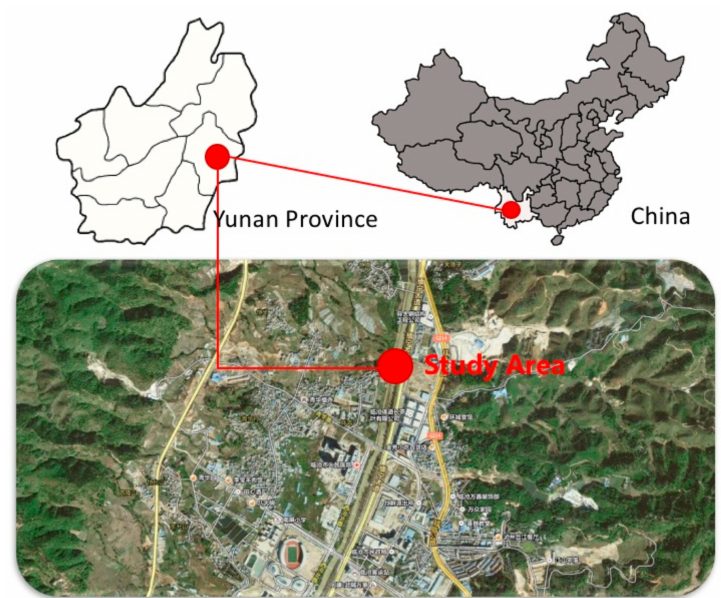
Figure 6. Lincang Technology Innovation Park (LCTIP) Location.